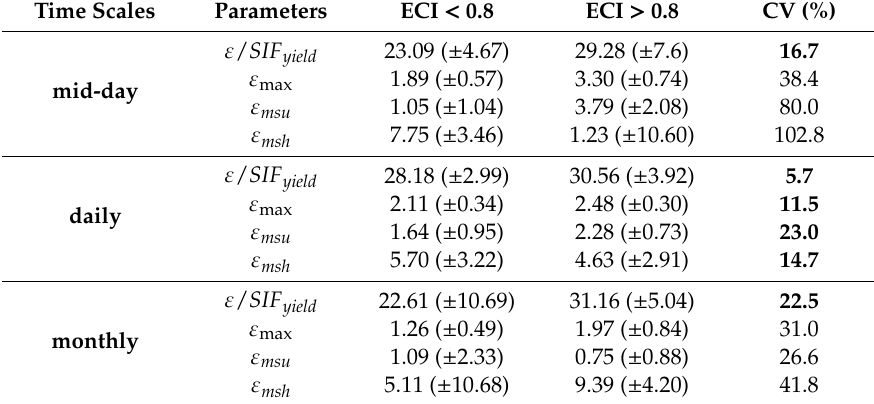
Table 3. The posterior estimations and the coe ffi cients of variation (CV = standard deviations /